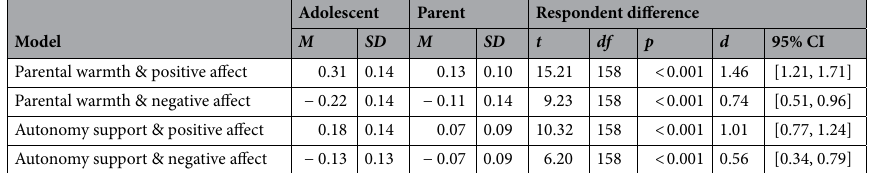
Table 4. Differences in family-specific estimates between adolescents’ and parents’ reported parenting (H3). 95% CI = 95% confidence interval.